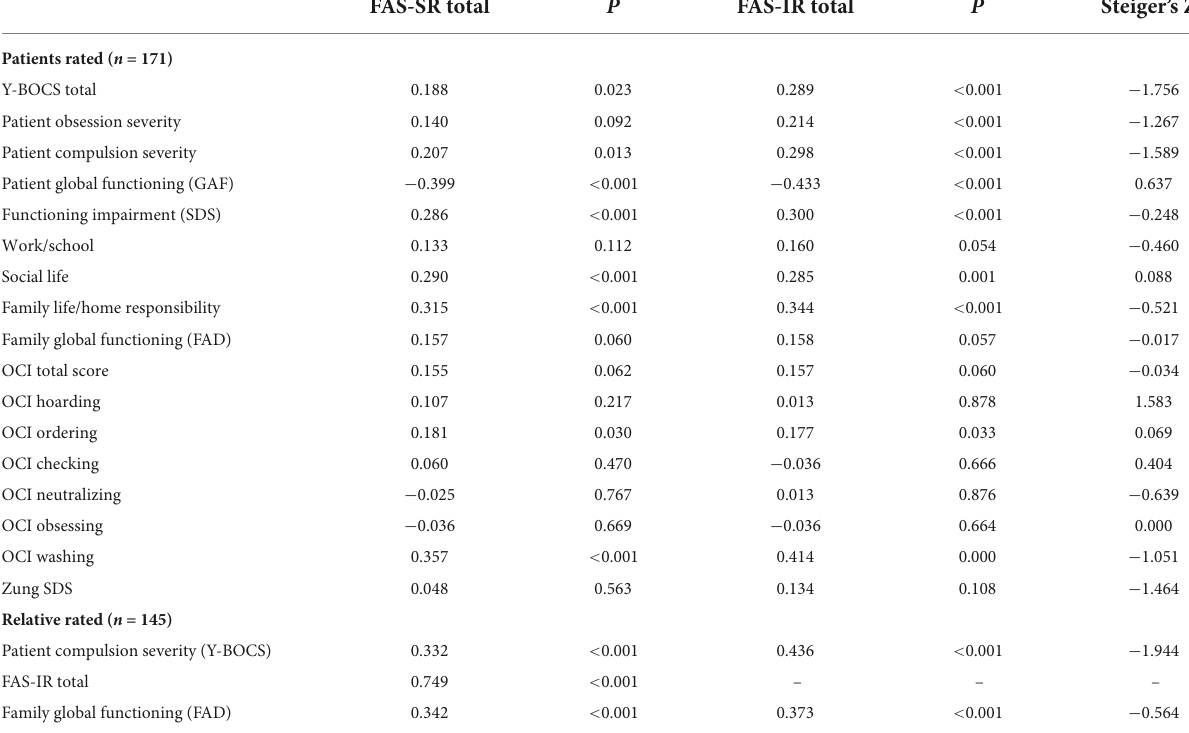
TABLE 5 Convergent validity of FAS-SR with criterion measures as compared to